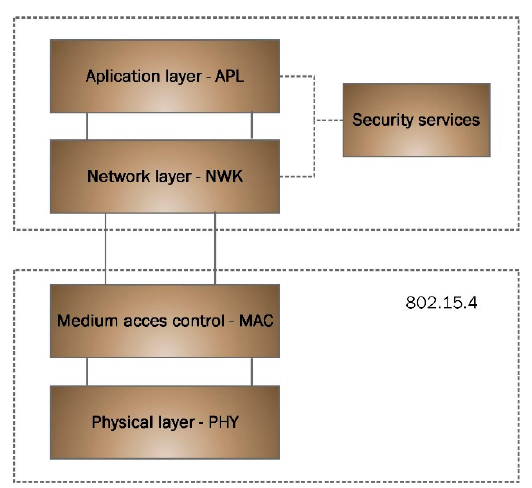
Figure 2. Layers model.